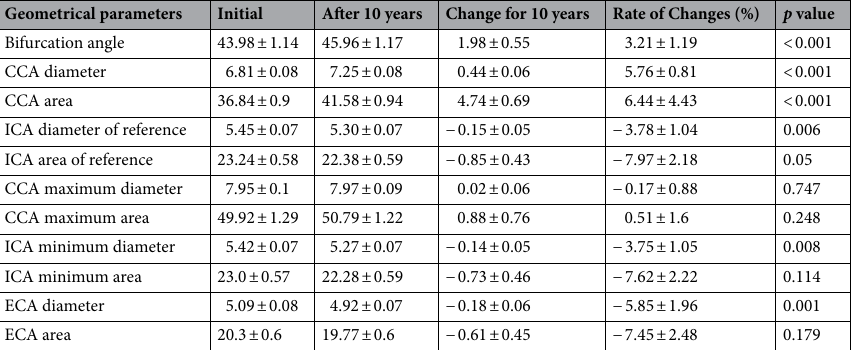
Geometrical parameters